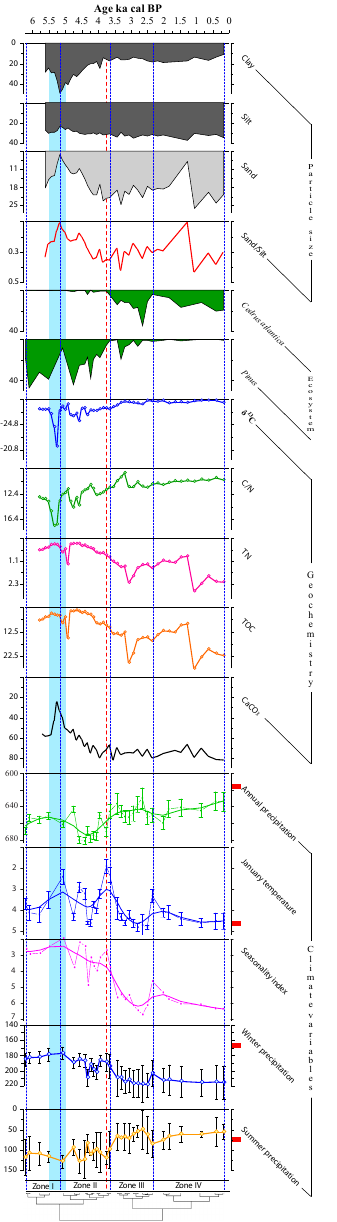
Figure 3. Diagram showing the sediment fractions (clay, silt, and sand / silt ratio), the pollen percentages of Cedrus atlantica and Pinus , geochemical elements (delta 13 C [ δ 13 C‰], nitrogen-to- carbon ratio [C / N], total organic carbon [TOC], total nitrogen [NT]) and carbonates concentrations (CaCO 3 ), January mean tem- perature ( T jan ), annual precipitation ( P ann ), winter and summer pre- cipitations ( P w and P s ), and precipitation seasonality index (SI). The red rectangles are pointing the values of present-day T jan , P ann , P w , and P s (HCEFLCD, 2004); the red line shows the limit 3.7kacalBP; and the blue rectangle shows the time interval of the cold phase 5.2kacalPB.